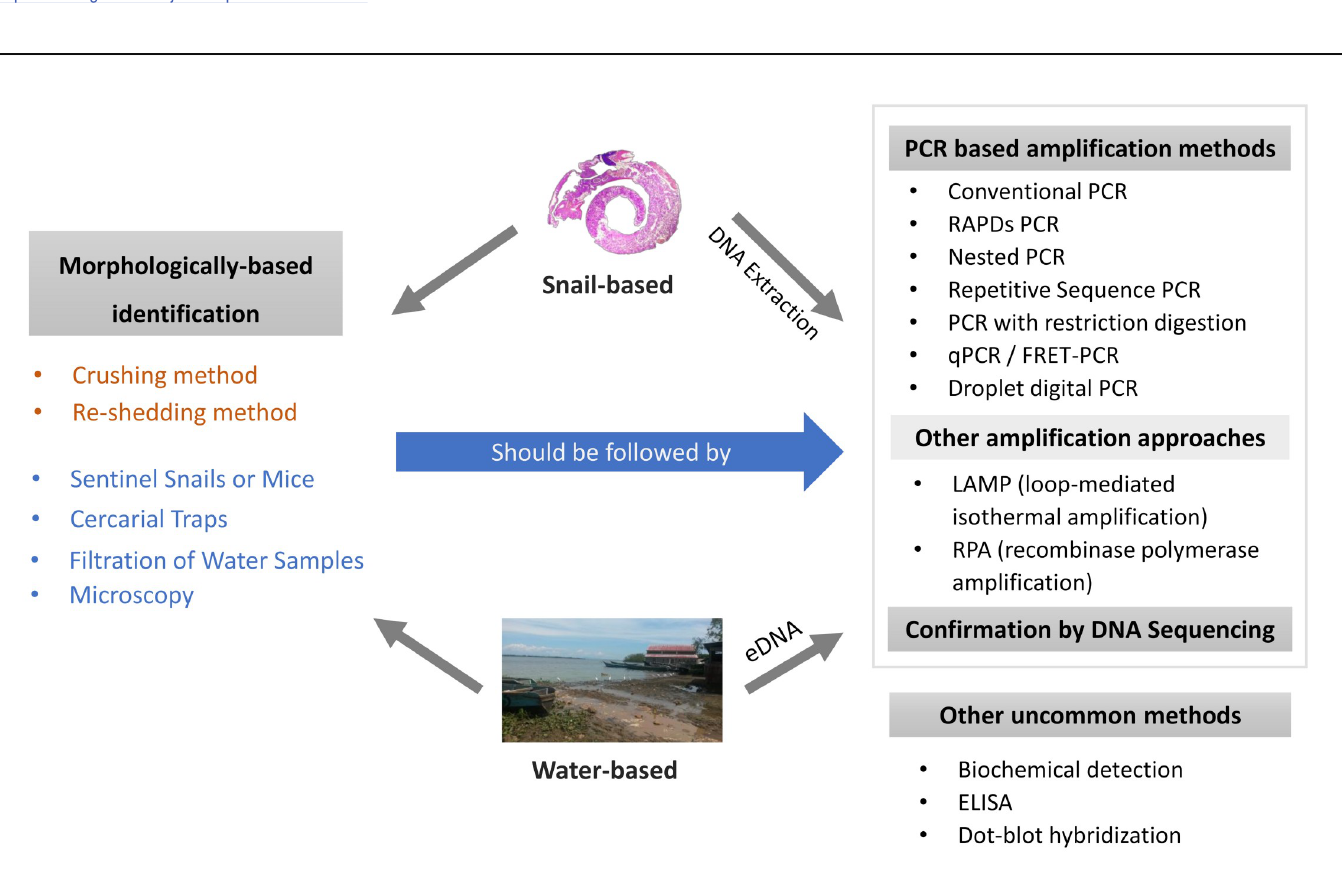
Fig 1. Shown are methods for detecting schistosome infections in snails or for detecting schistosome or snail signals in the water. Identification protocols rely on traditional morphological means or, increasingly, sequence-based identifications. With respect to finding infections in snails, the traditional technique of isolating and shedding snails for cercariae is widely practiced, but alternative methods, mostly relying on amplification of schistosome DNA sequences by a variety of means, is also widely practiced. Additional follow up techniques may be required to provide sufficient sequence information for identification. A variety of techniques has been devised to detect schistosomes in the water column ranging from using sentinel mice to collect cercariae from the water to collection of environmental DNA samples containing DNA from intact or disintegrated bodies of schistosomes or their snail hosts. Again, follow-up sequencing may be required to confirm species identifications.